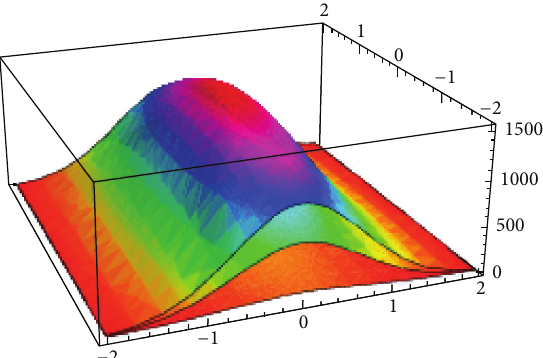
Figure 8: Dimensional graph of the fuzzy solution for 𝑡 = 200 involving only diffusion.